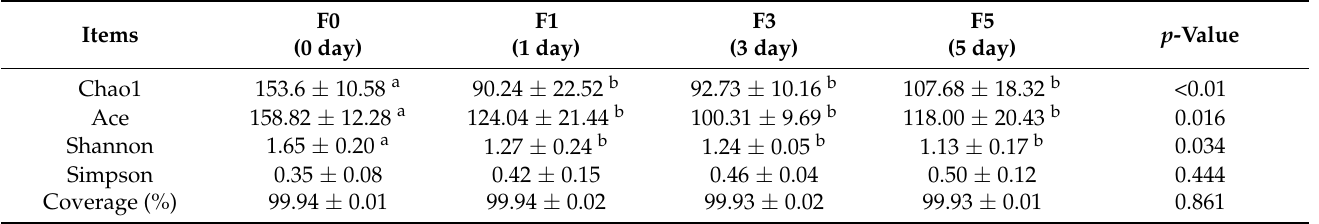
Table 4. Alpha diversity of tea residue mixture during L. plantarum and B. licheniformis